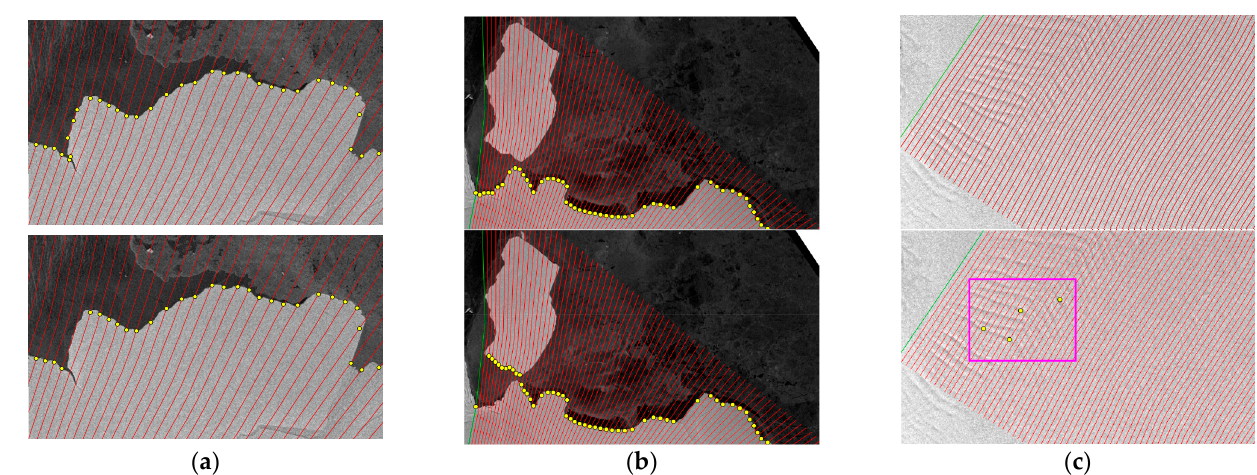
Figure 5. Frontal point extraction on sample Sentinel-1 SAR images using the proposed algorithm (upper) and the comparison method (bottom). ( a ) 26 March 2015; ( b ) 24 October 2019; ( c ) 22 September 2015.